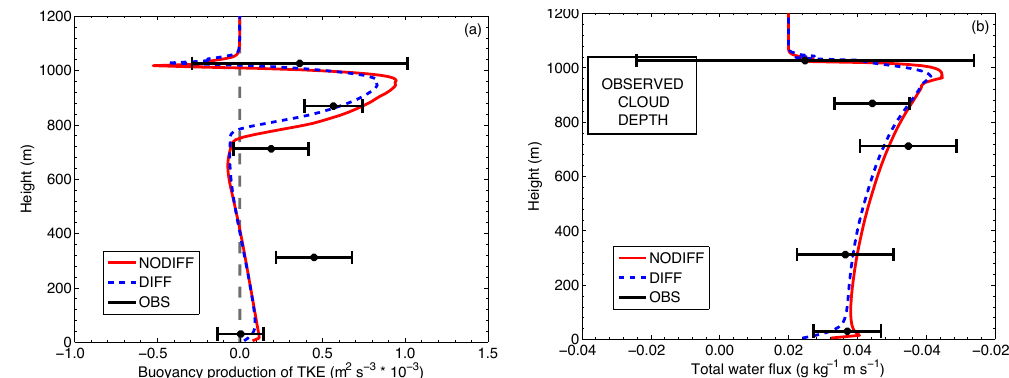
Fig. 3. Comparison of resolved-scale flux profiles between CIRPAS in-situ observations (data points) and LES output (lines). Observations show means (symbol) and computed errors (error bars) over the five flight legs. Errors are computed with propagation of measurement uncertainties in Table 2. LES output are domain-averaged and temporally averaged over the sixth hour of simulation. Times of observations and LES output coincide. The gray dashed line in (a) indicates zero values for visualization.